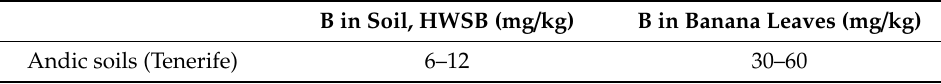
Table 2. B (mg / L) determined in Andic soils (mg / kg) and banana leaves (mg / kg). B in Soil, HWSB (mg /